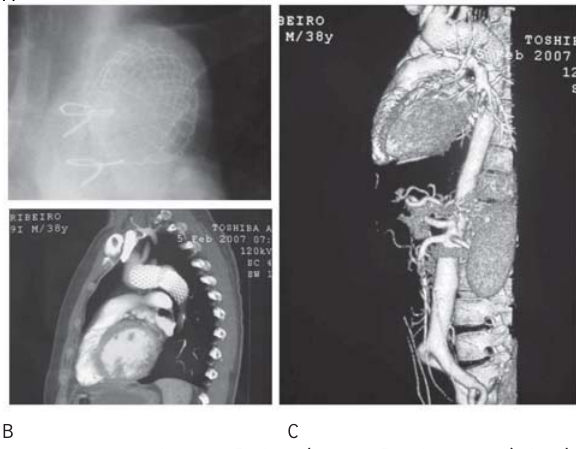
Fig. 2 - Imagens de controle da prótese realizadas no período pós- operatório tardio. A - Radiografia simples de tórax ilustrando a diferente trama metálica do stent utilizado. B - Angiotomografia da aorta torácica com contraste iodado dentro do stent. C - Imagem da aorta operada caracterizando-se a ausência de